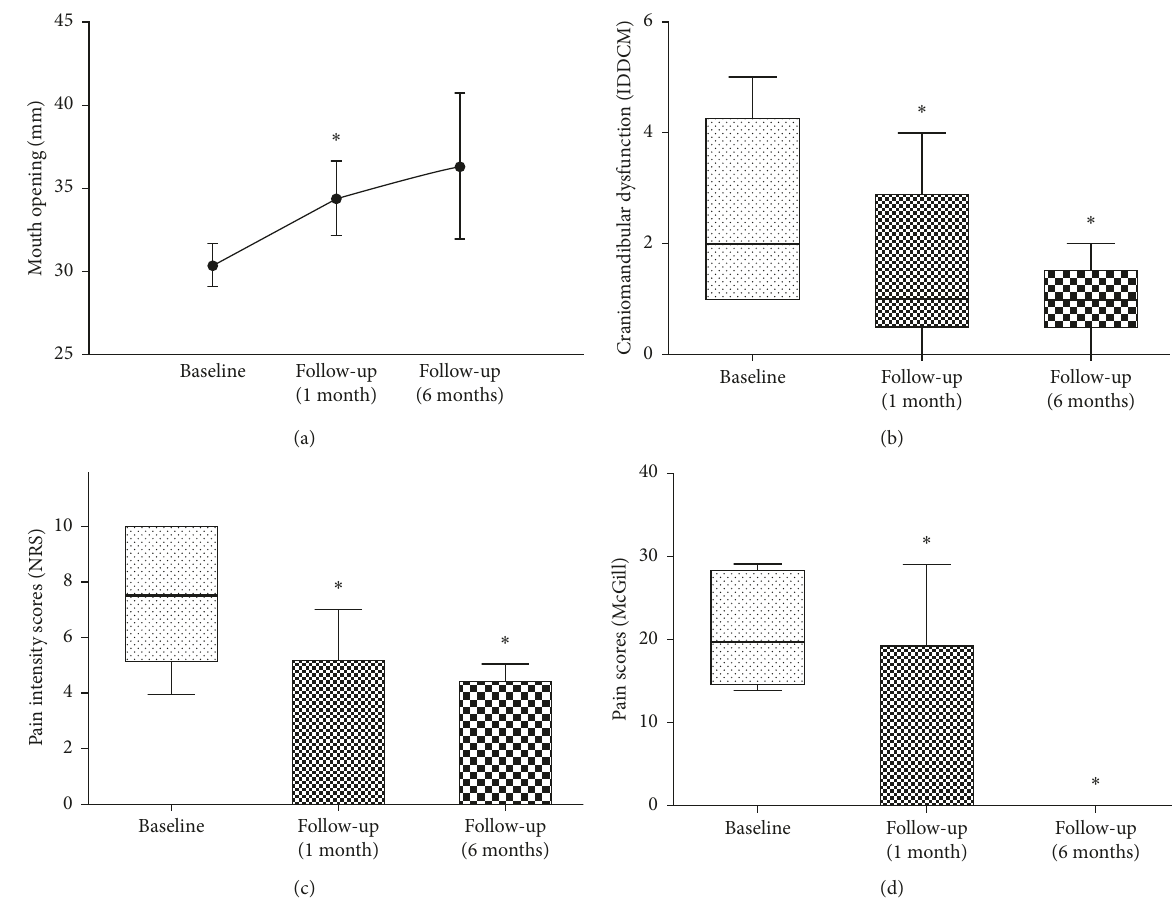
Figure 1: (a) Improvement on mouth opening without pain (measured in mm) at 1 and 6 months after treatment. This parameter was p analyzed only on patients who showed limited mouth opening at baseline. Bars represent standard deviation (SD). Student’s t -test; (cid:31) 0 . 039 ; n 5 patients (1-month follow-up) and 3 patients (6-month follow-up). (b) Decrease in scores of craniomandibular dysfunction ∗ (cid:31) (IDDCM-Helkimo Index) at 1 and 6 months after treatment. Box and whisker show quartiles, the band inside the box is the median, and the p p ends of the whiskers represent minimum and maximum values. Wilcoxon signed rank test; 0 . 034 (1-month follow-up) and 0 . 038 (cid:31) (cid:31) (6-month follow-up); n 10 patients (1-month follow-up) and 8 patients (6-month follow-up). (c) Decrease in NRS pain intensity at 1 and 6 ∗ ∗ (cid:31) months after treatment. This parameter was analyzed only on patients who showed pain at baseline. Box and whisker show quartiles, the band inside the box is the median, and the ends of the whiskers represent minimum and maximum values. Wilcoxon signed rank test; p p 0 . 018 (1-month follow-up) and 0 . 05 (6-month follow-up); n 6 patients (1-month follow-up) and 4 patients (6-month follow- (cid:31) (cid:31) (cid:31) up). (d) Decrease in McGill pain scores at 1 and 6 months after treatment. This parameter was analyzed only on patients who showed pain at ∗ ∗ baseline. Box and whisker show quartiles, the band inside the box is the median, and the ends of the whiskers represent minimum and maximum values. Wilcoxon signed rank